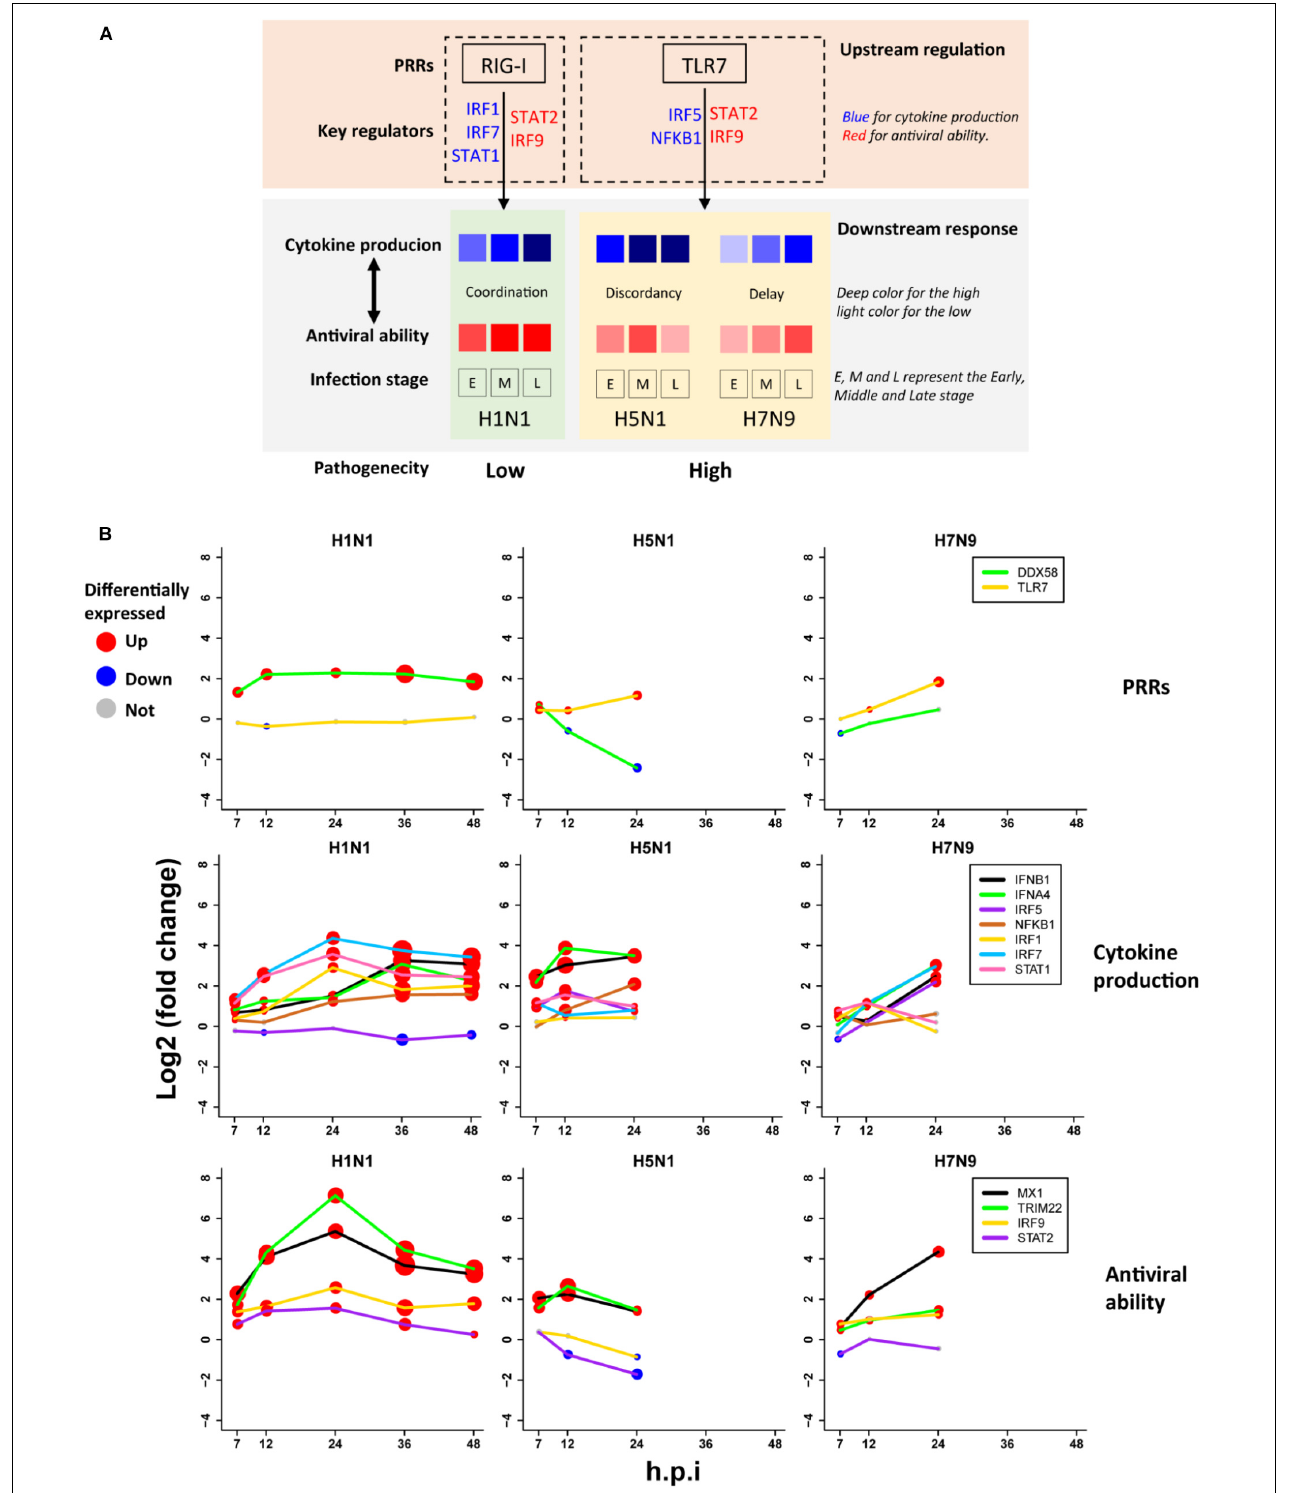
FIGURE 6 | The pathogenesis model of avian IAV (A) A representation of the proposed pathogenesis model. (B) Dynamic expression levels of key genes involved in the pathogenesis model. The node size represents significance of gene differential expression, and the node color represents up-regulation (red), down-regulation (blue) or not significant